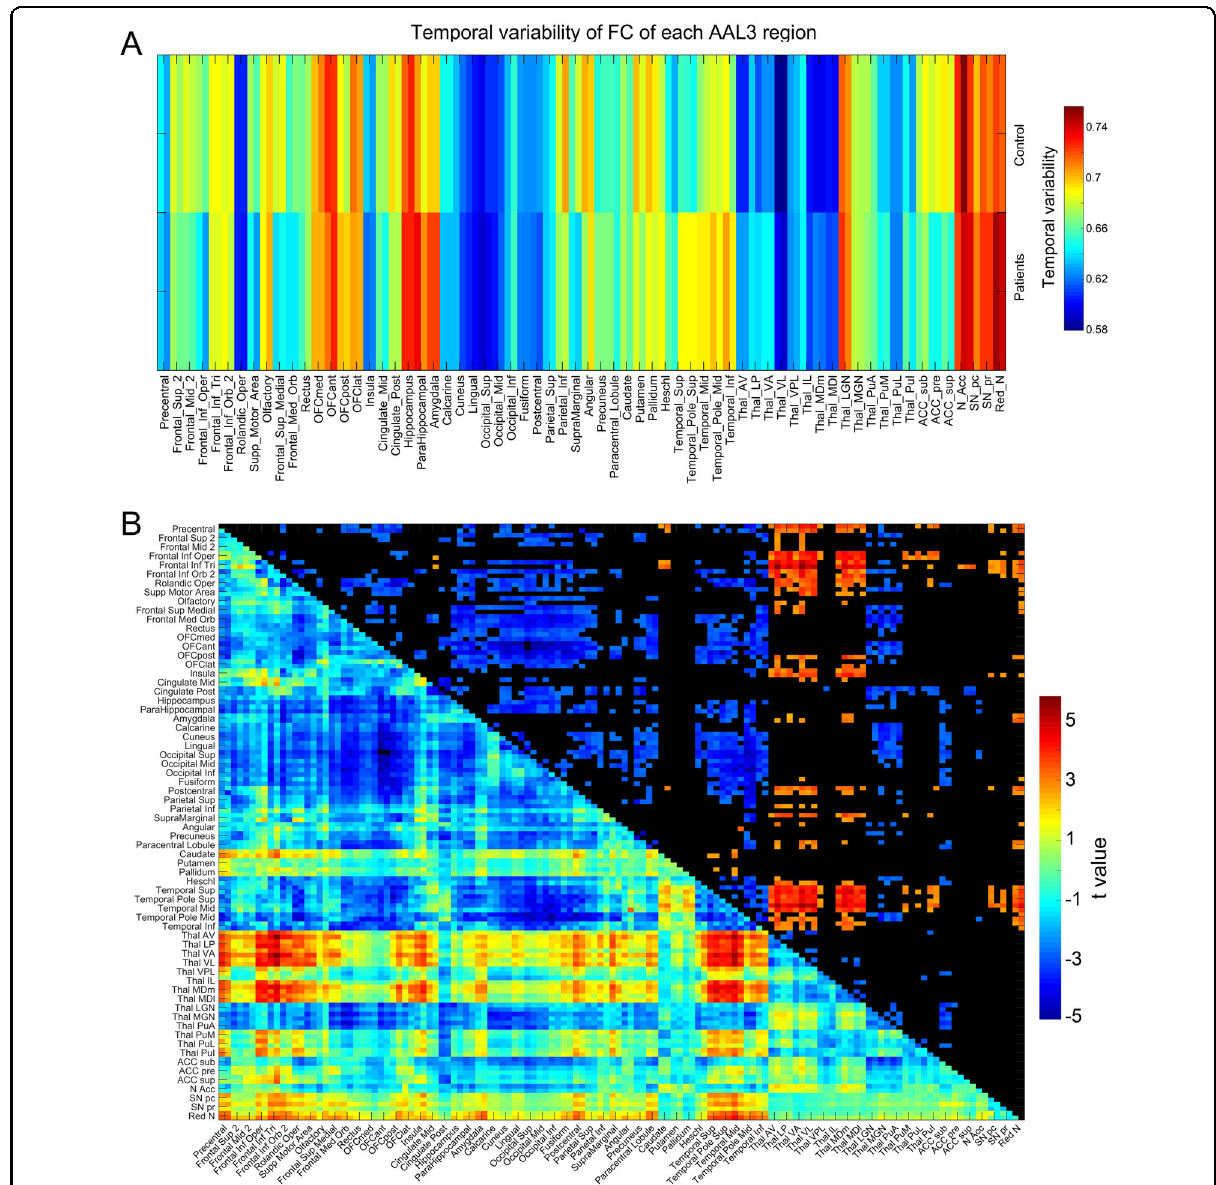
Fig. 3 Higher temporal variability of functional connectivity of some brain regions in fi rst episode schizophrenia. A The temporal variability of the functional connectivity of different AAL3 regions in the fi rst episode schizophrenic and control groups. B The functional connectivity of AAL3 areas for the fi rst episode schizophrenic group minus controls. The lower left shows the t -value for the difference in functional connectivity of patients - controls; the upper right shows the signi fi cantly different functional connectivities after FDR correction, with red showing higher and blue showing lower functional connectivity in patients -